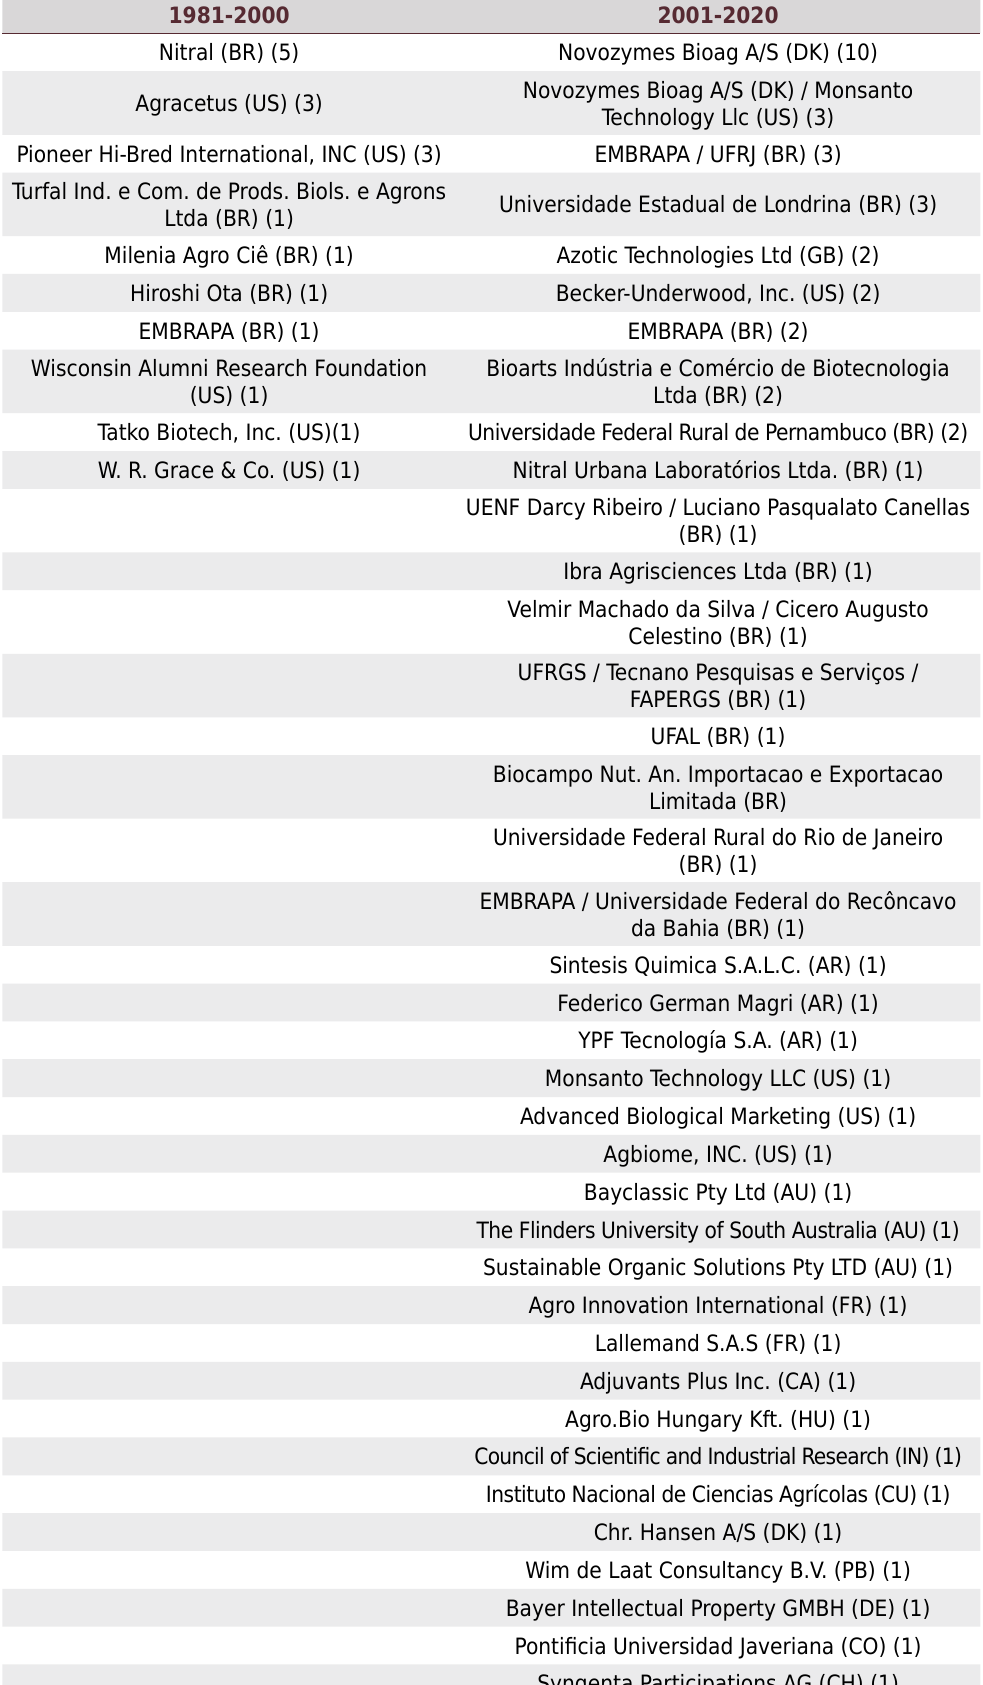
Table 3. Number of filed patents by holders in Brazil from 1981 to 2000 and 2001 to